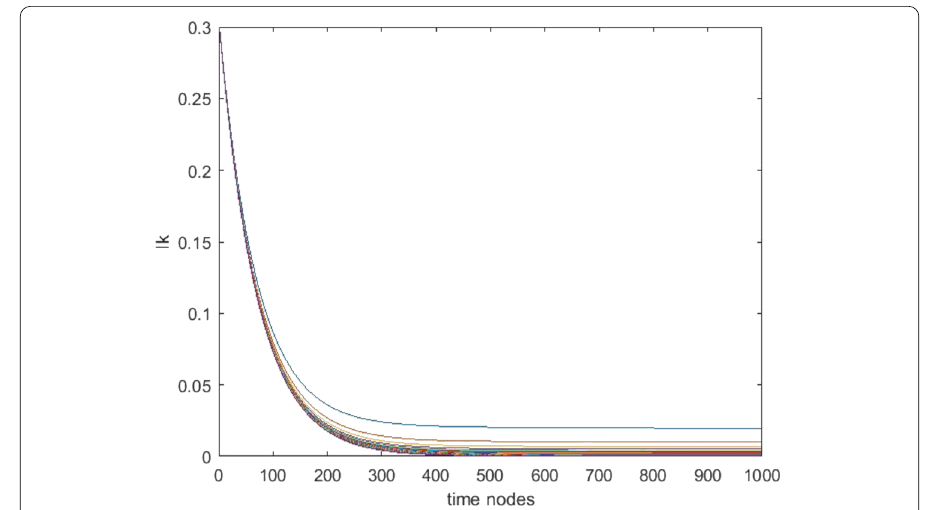
Figure 1 Evolution of the state I k for system (3) at different k